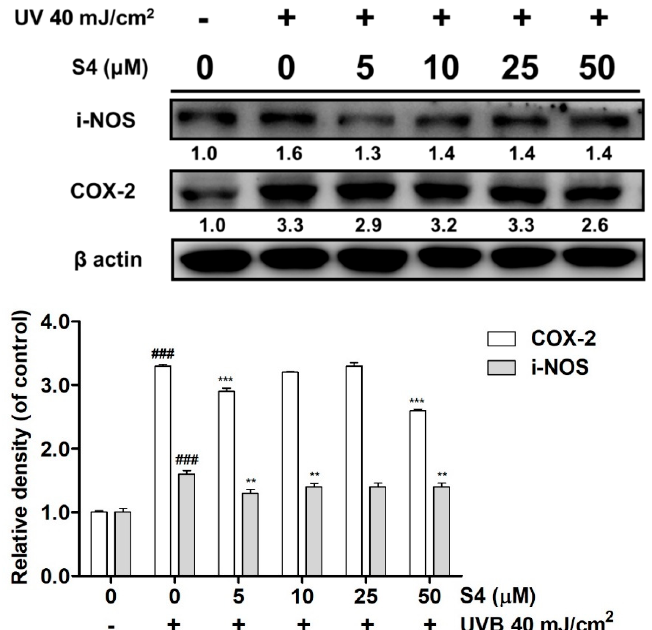
Figure 7. Effect of S4 on UVB-induced i-NOS and COX-2 in human skin fibroblasts. The results were